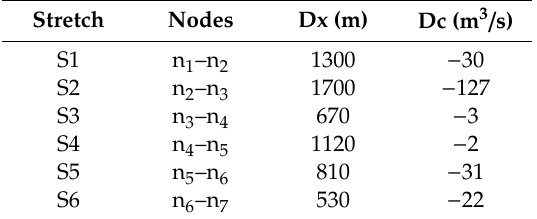
Figure 4. Scheme of the prediction system created. Here, c i is the airflow at the beginning of the stretch (m 3 / s), c f is the airflow at the end of the stretch (m 3 / s), x i is the initial relative position (m), and x f is the final relative position (m). Table 1. Characteristics of the stretches used in the model.